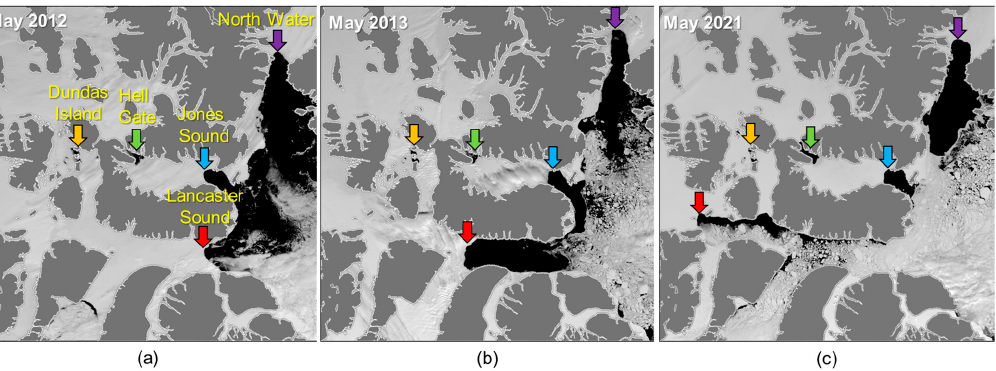
Figure 2. Satellite images with land mask showing the location of five recurring polynyas (North Water, Dundas Island, Hell Gate, Jones Sound and Lancaster Sound) in the eastern Arctic for ( a ) May 2012, ( b ) May 2013 and ( c ) May 2021. Ice arch location for each polynya is shown with a color- coded arrow. The location of the Lancaster Sound ice arch can vary by more than 500 km, even extending into Barrow Strait, significantly changing the area of the polynya.